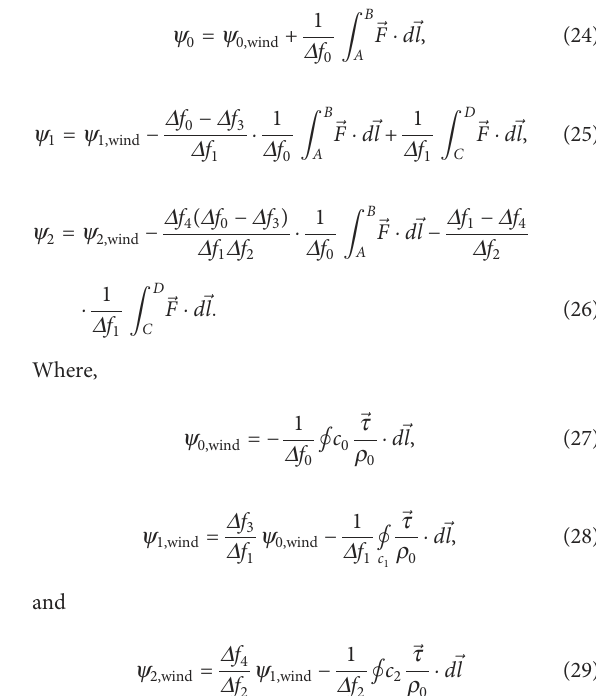
Case 3: The western island contains the middle island in latitude and partially overlaps with the eastern island, and the middle island and the eastern island moderately overlap in latitude (Figure 4).